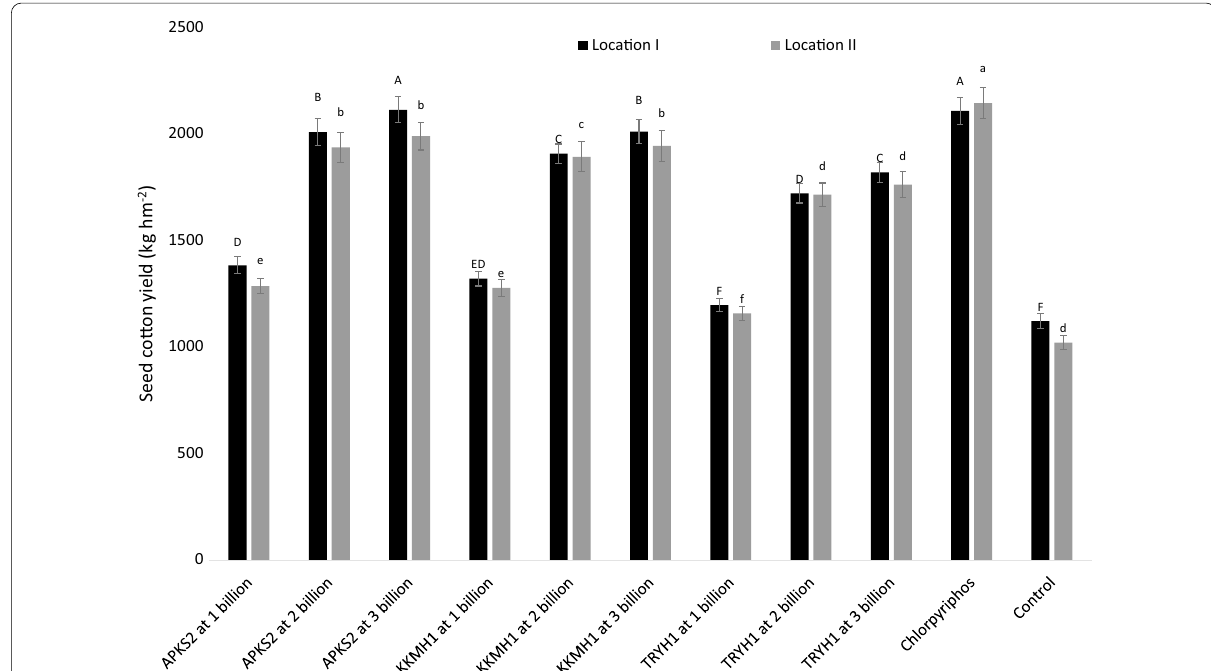
Fig. 1 Effect of EPN strains at three application rates on yield of cotton infested with Helicoverpa armigera (location 1) and Earias vittella (location II). Bars with the same letter do not differ significantly according to Tukey–Kramer test at P < 0.05. Capital letter represents field experiment I and small letter denotes field experiment II